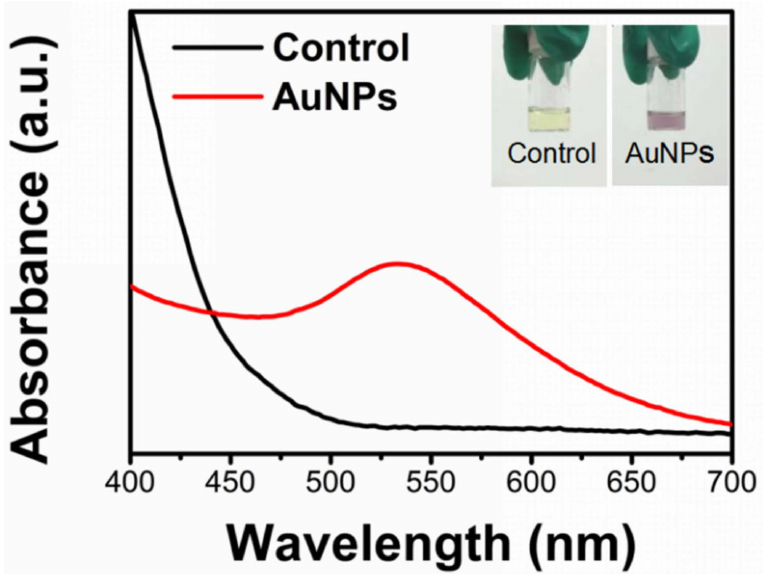
Figure 1. General morphology and UV-vis results of AuNPs synthesized with Chlorella.